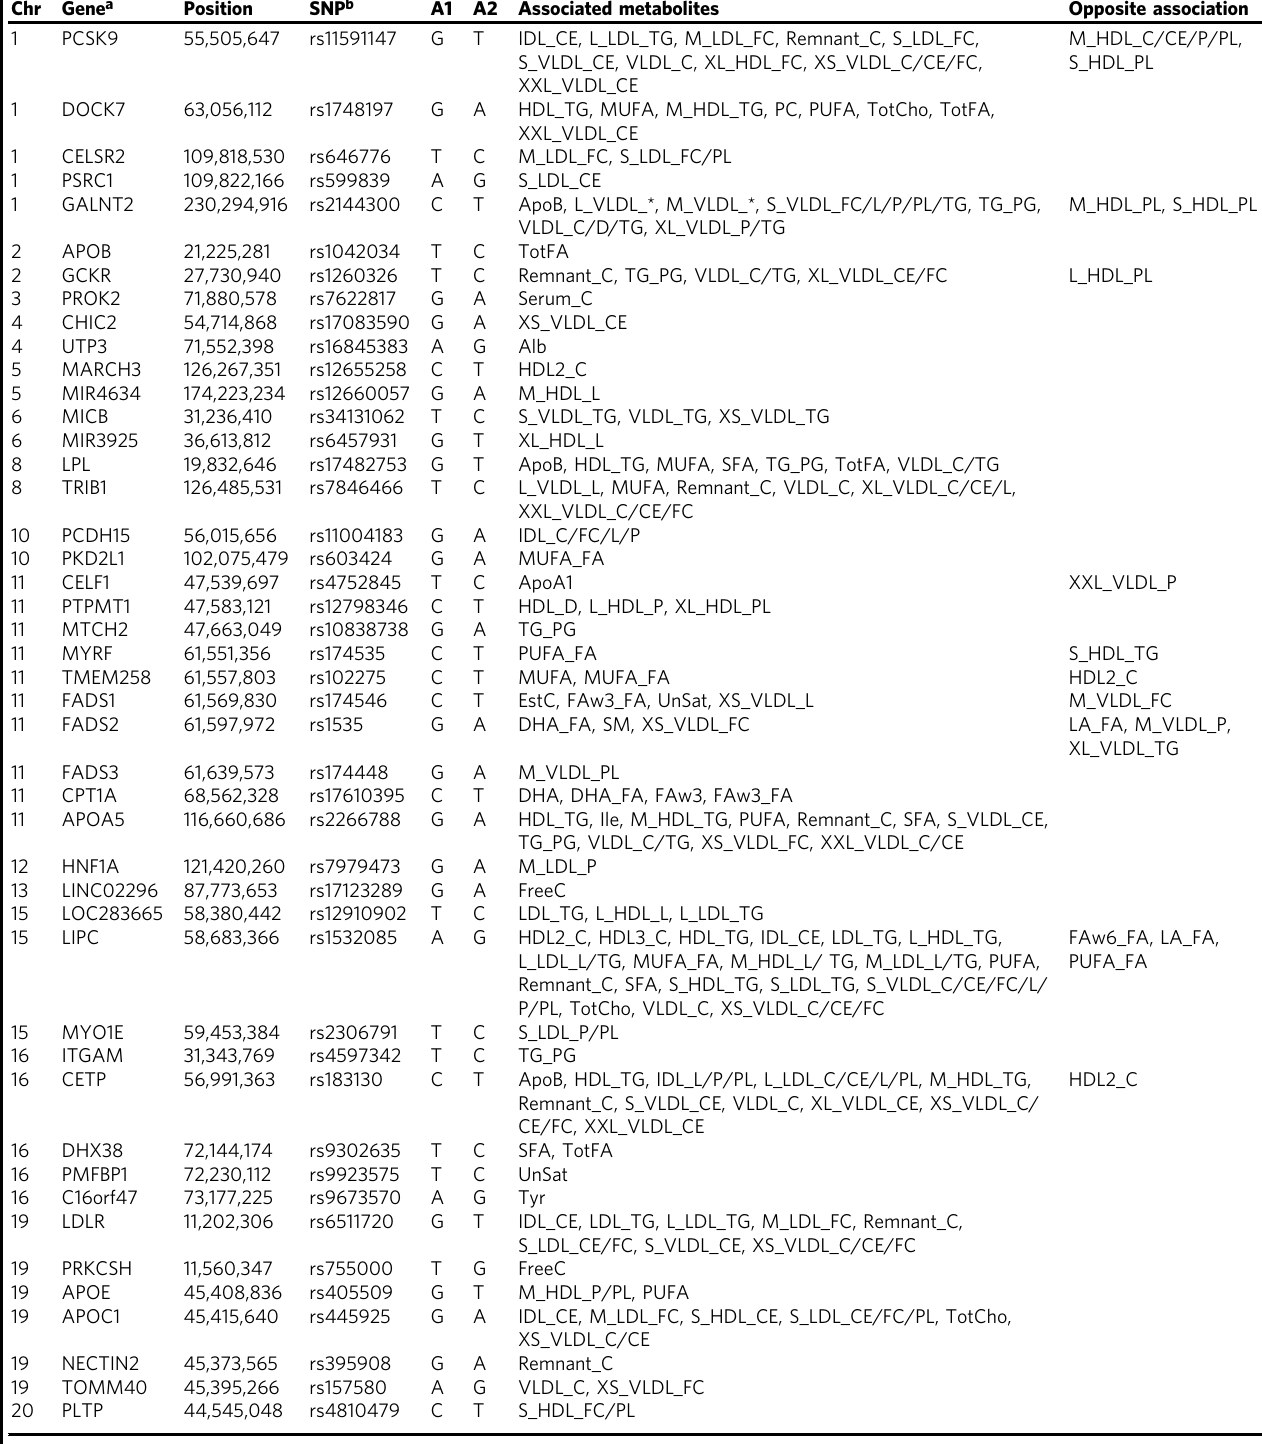
Table 1 New gene – metabolite